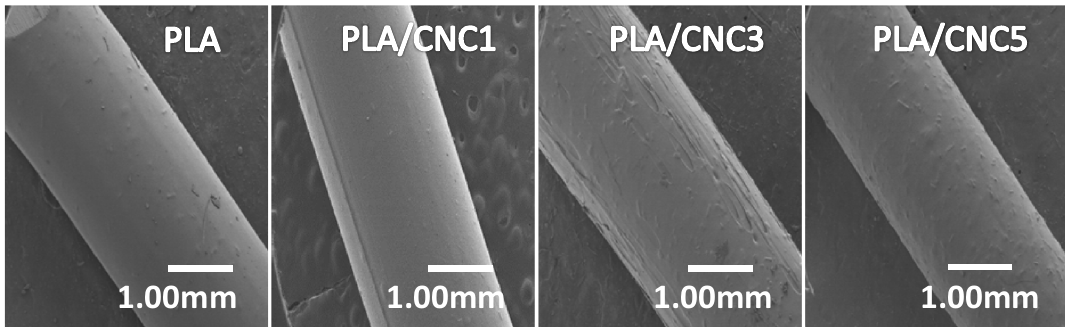
Figure 1. SEM images of extruded PLA and PLA/CNCx composite